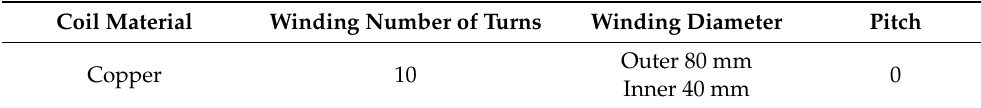
Figure 10. Reference circular coil model. Table 5. Circular coil model